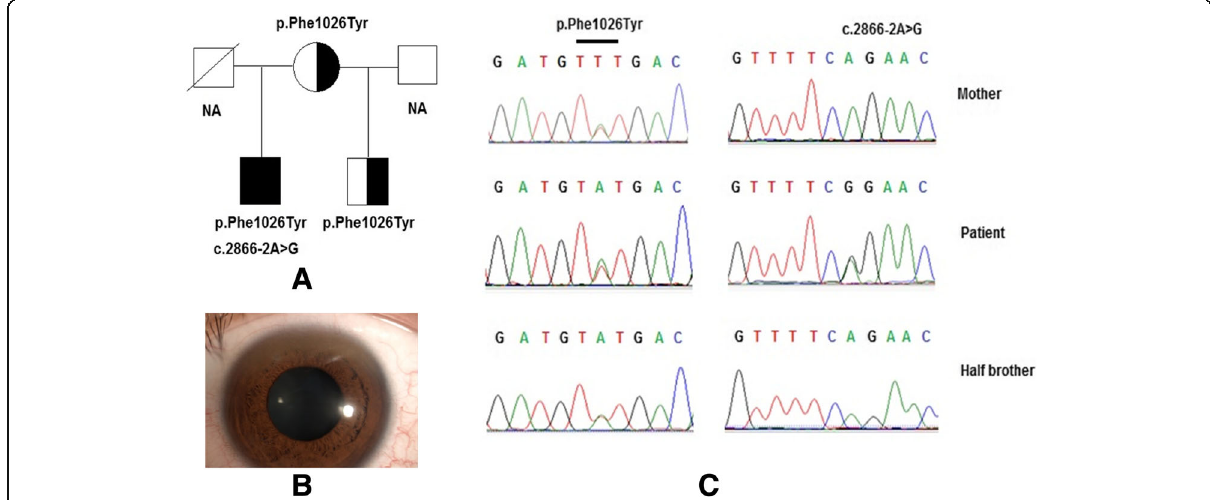
Fig. 1 Mutations of the ATP7B gene were identified by sequencing in patient 1 and his family. Pedigree of patient ’ s family ( a ), the Kayser-Fleischer ring around the cornea of patient ’ s eye ( b ) and mutations ( c ) of ATP7B gene were identified, including a compound heterozygous mutation p.Phe1026Tyr and heterozygous mutation c.2866-2A >